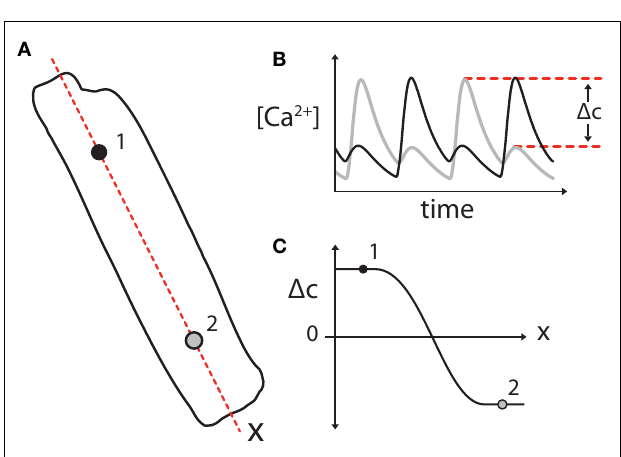
FIGURE 12 | Ca 2 + -waves predispose to subcellular alternans in an isolated rabbit ventricular myocyte. Line-scan data of Ca 2 + fluorescence along the length of an isolated rabbit ventricular myocyte is plotted with time on the horizontal axis and distance on the vertical axis (distance scale bar is 50 μ m). Ca 2 + -waves were induced by application of BayK8644 + Isoproterenol (thereby inducing Ca 2 + -overload). (A) Two spontaneous Ca 2 + -waves are seen to arise near